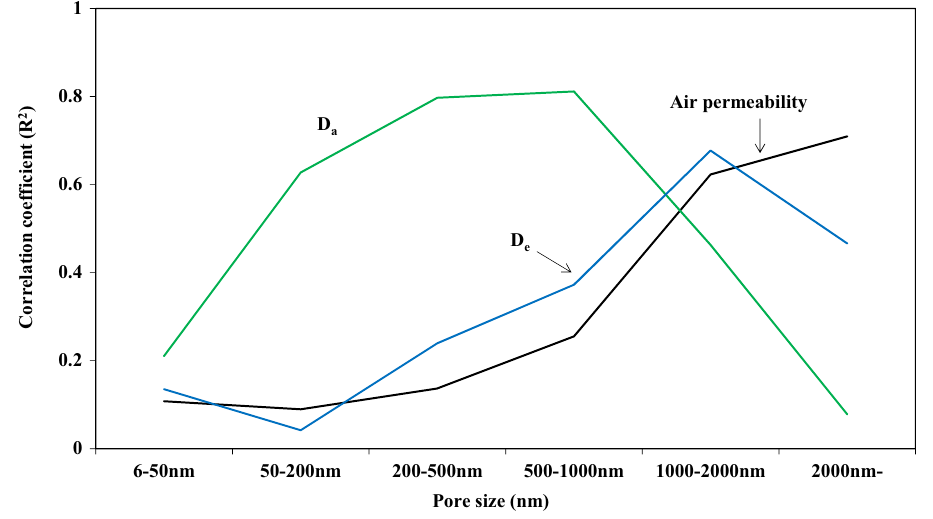
Fig. 13 Correlation coefficient of durability indicators for laboratory prepared concrete at different pore